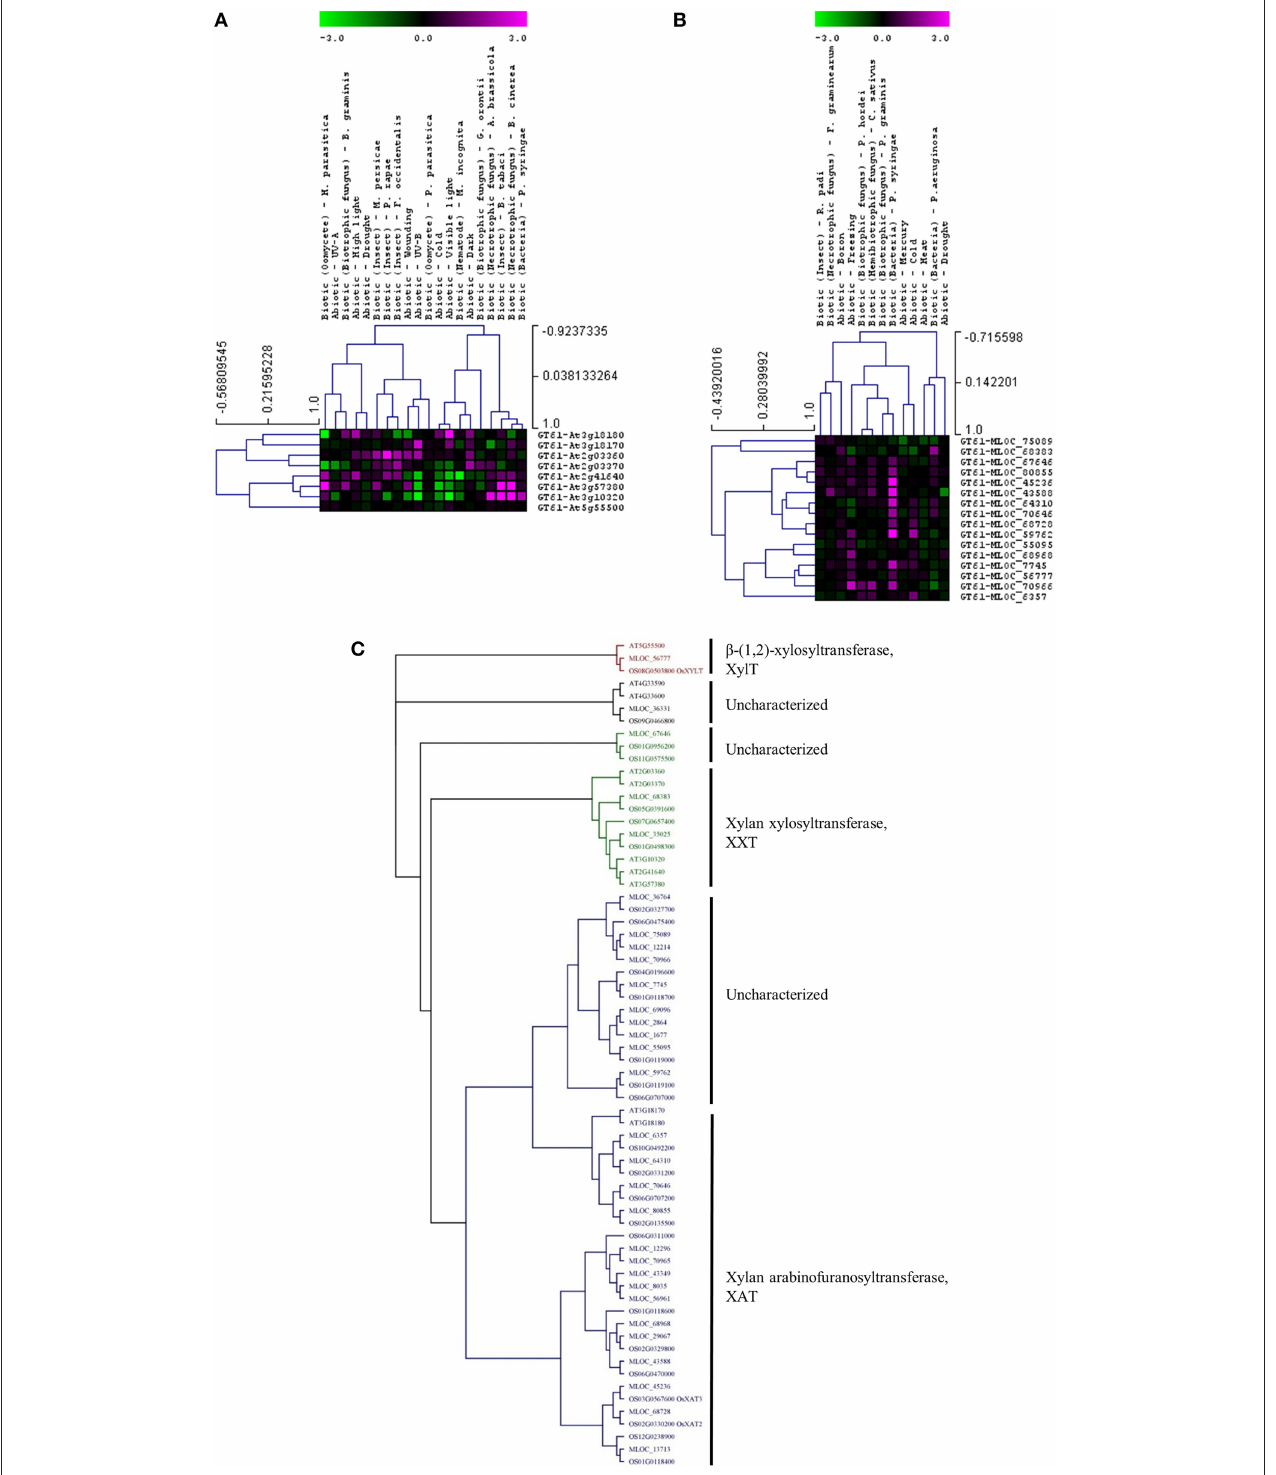
FIGURE 4 | Analysis of GT61 family members following abiotic and biotic stresses in Arabidopsis (A) and barley (B). Transcript abundance was determined through meta-analysis of microarray datasets collected from the Plant Expression Database (PLEXdb; Dash et al., 2012) using the experiments listed in Table 2 . Values show the average log(2)-fold induction for representatives of each CAZy gene family present on the Arabidopsis Affymetrix 22K ATH1 genome array and the 22K Barley1 genechip. Hierarchical clustering was performed based on the Pearson correlation coefficients across each dataset and CAZy family. (C) Phylogenetic tree of GT61 family members from Arabidopsis, barley, and rice with putative functions assigned for each clade.